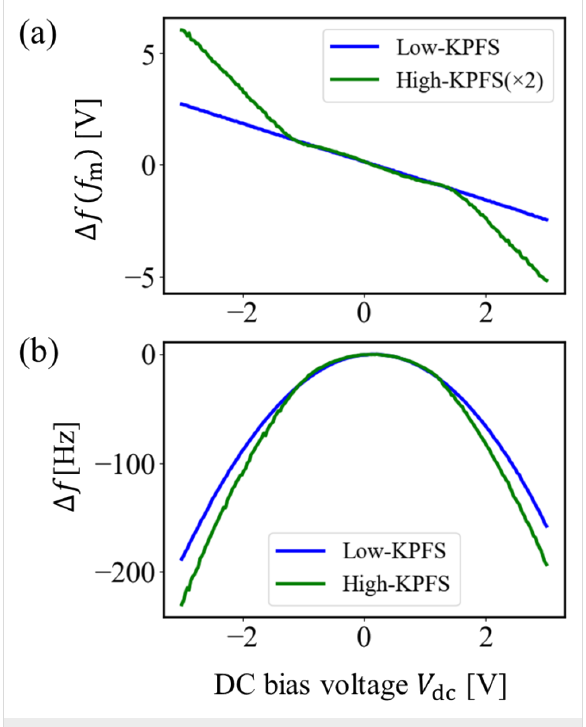
Figure 9: (a) Δ f ( f m )– V dc curves and (b) Δ f – V dc curves obtained on the p-type Si surface. The tip–sample distance was set with Δ f set = − 200 Hz ( z to ≈ 23 nm) when V dc = 3 V and V ac = 0.5 V were applied between the tip and the